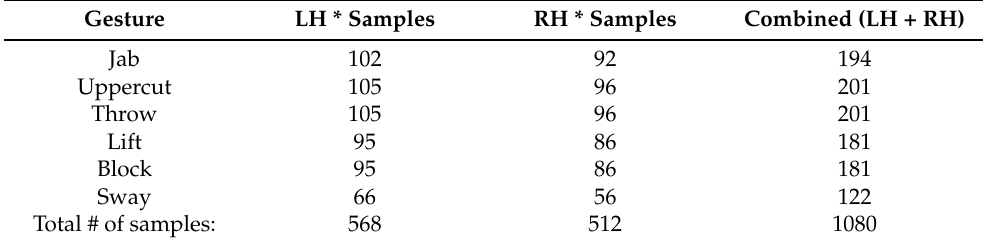
Table 1. Number of samples in the gesture dataset.